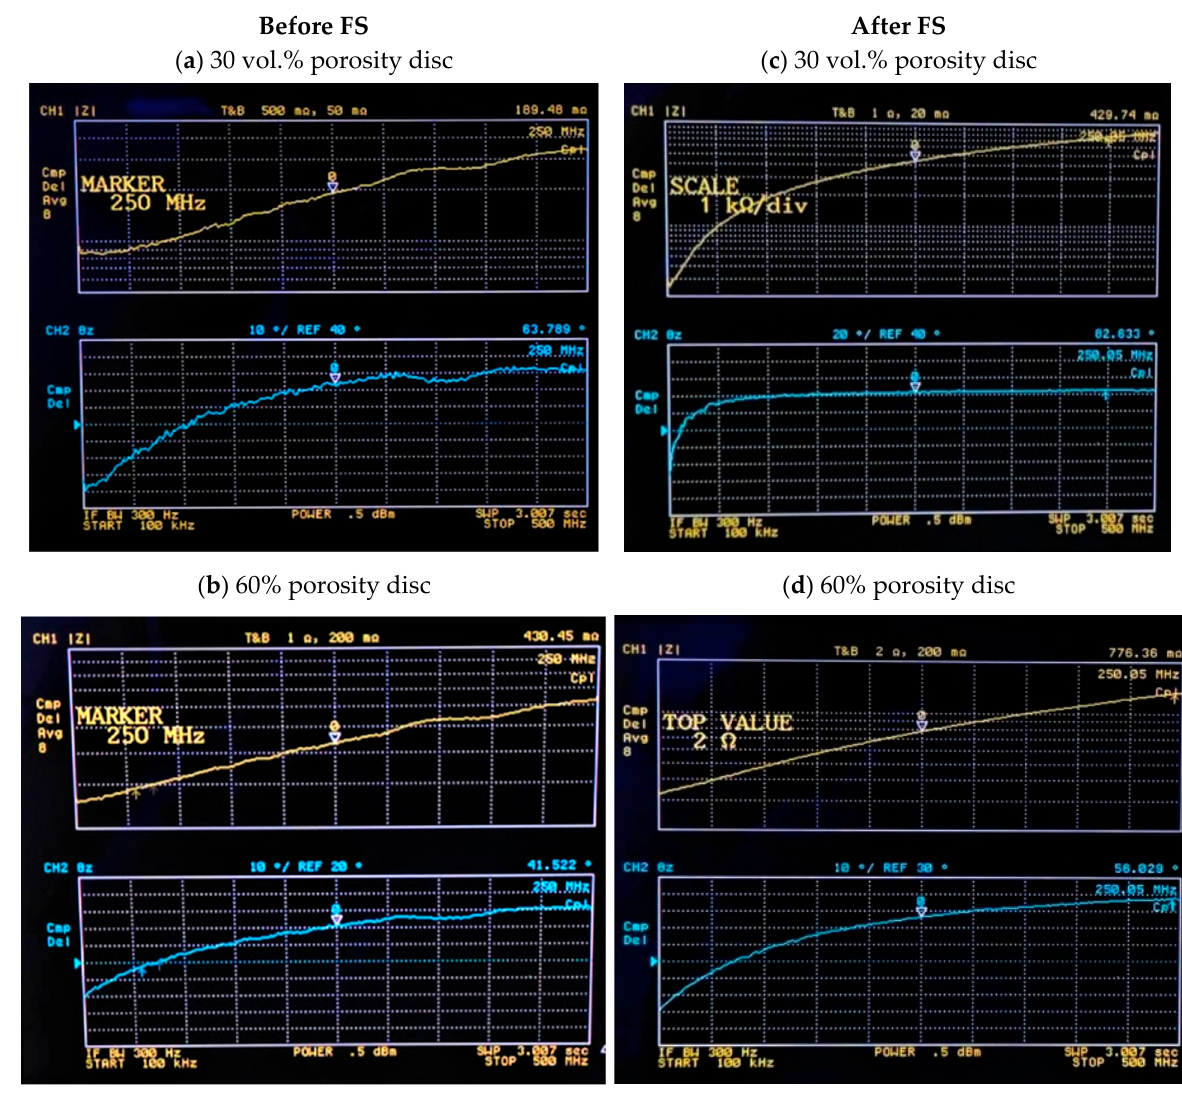
Figure 3. Graphs obtained with the modulus and phase impedance of titanium samples, with 30% and 60% porosity vol- ume. ( a ) sample with 30% porosity volume before FS, ( b ) sample with 60% porosity volume before FS, ( c ) sample with and 60% porosity volume. ( a ) sample with 30% porosity volume before FS, ( b ) sample with 60% 30% porosity volume after FS, and ( d ) sample with 60% porosity volume after FS. porosity volume before FS, ( c ) sample with 30% porosity volume after FS, and ( d ) sample with